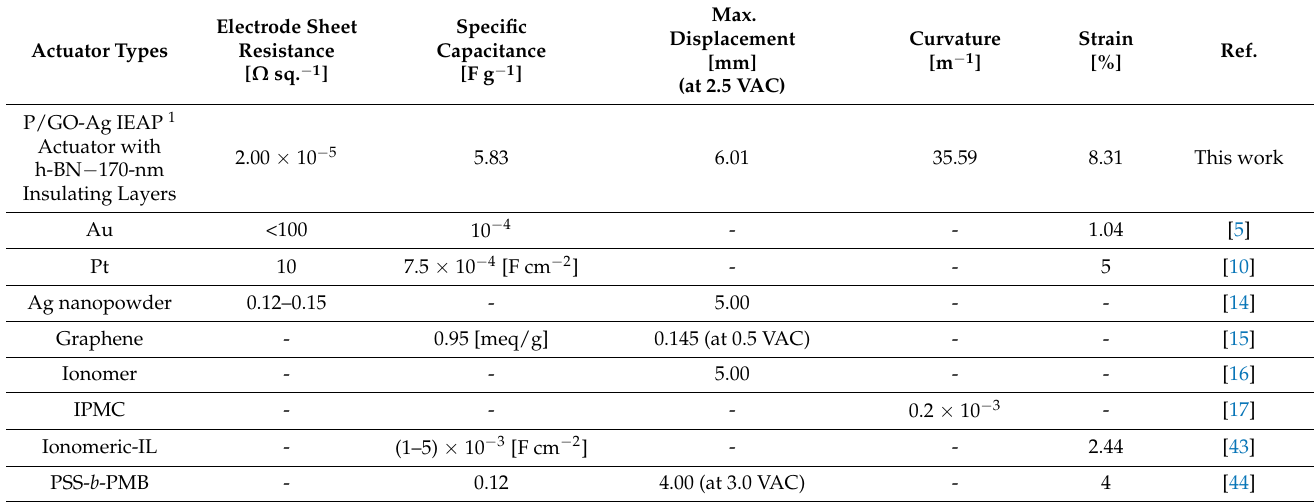
Table 2. Electrode, capacitance, and driving characteristics of various actuators from prior reports and the IEAP actuator with h-BN − 170-nm insulating layers.